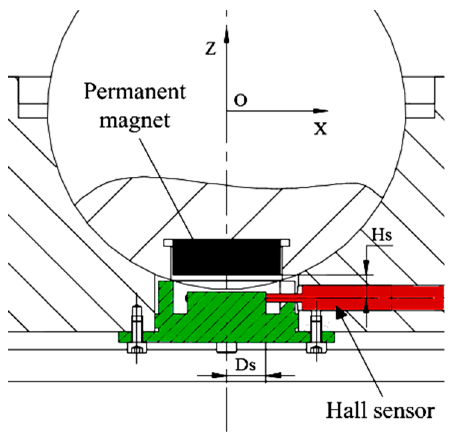
Figure 7. Diagram of the relative positions of the permanent magnet and Hall sensor.